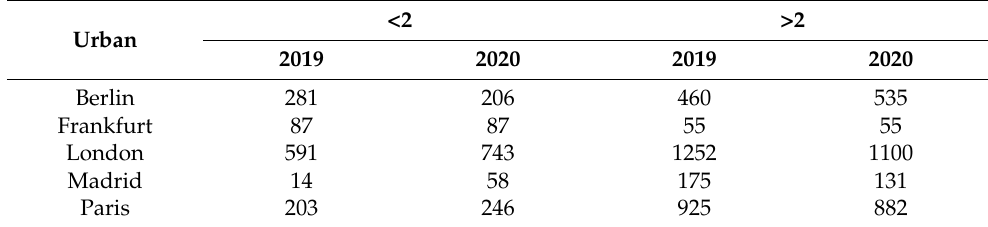
Table 4. Areas of each NUHI class in the two periods of lockdown and the year before it (km 2 ). <2 Urban